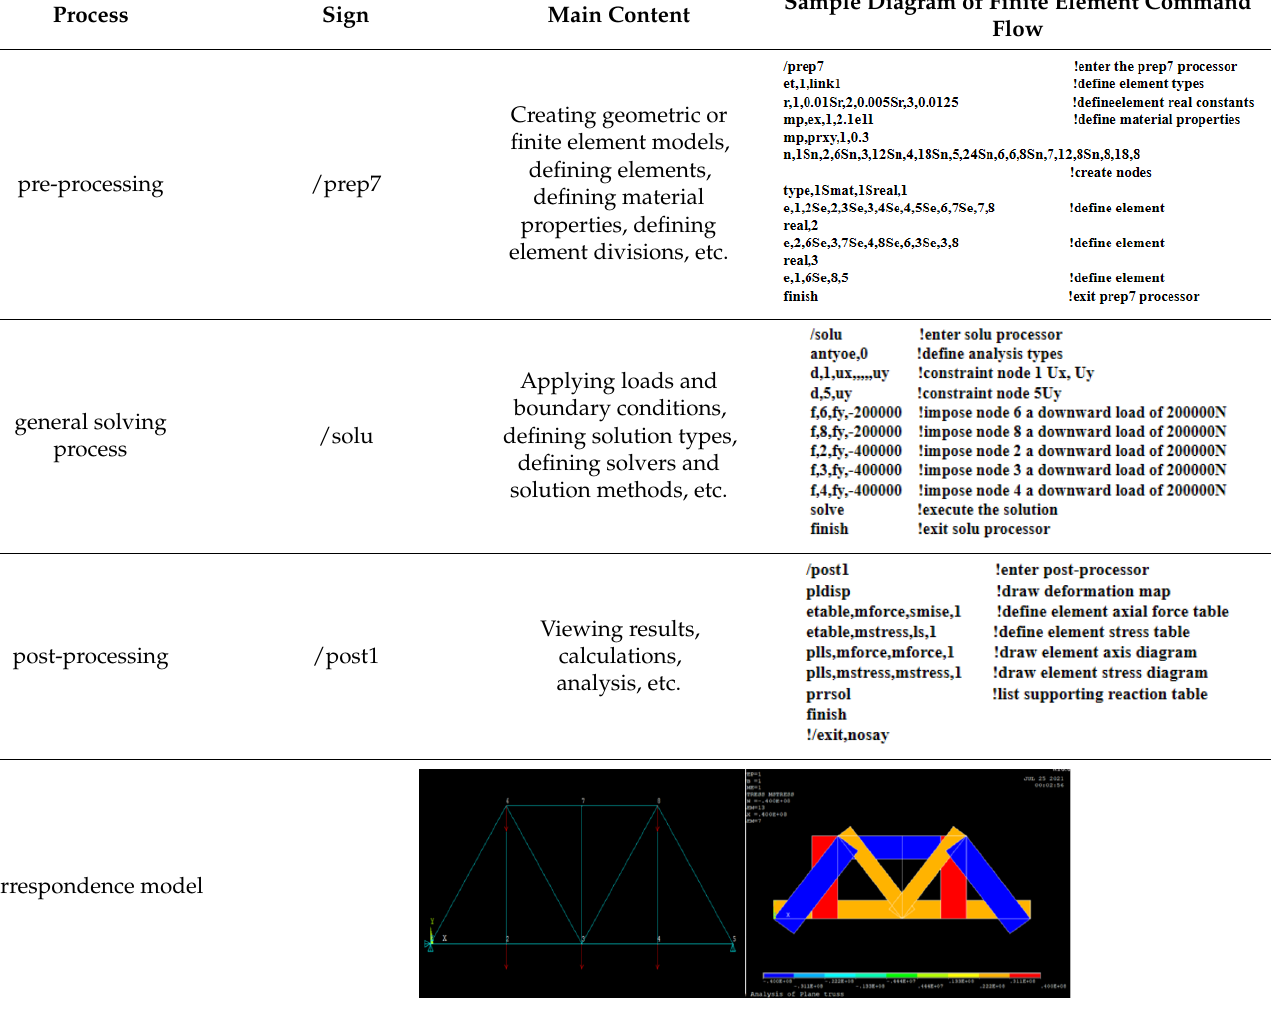
Table 2. Main content and example of finite element analysis.